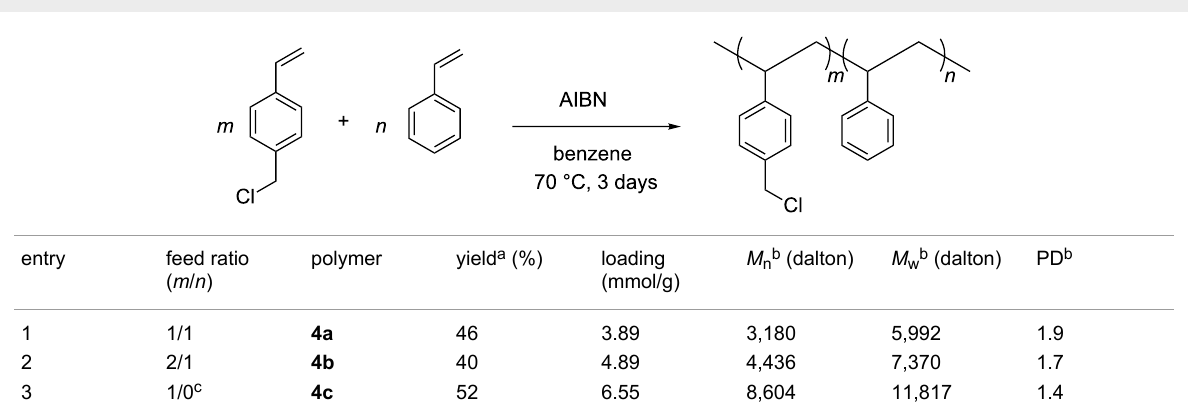
Table 1: Synthesis of non-crosslinked chloromethylated polystyrenes 4 .